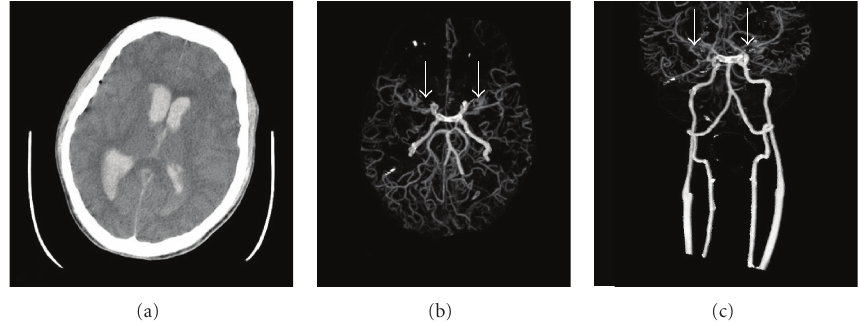
Figure 3: A 17-year-old boy was presented with sudden loss of consciousness and generalized seizure attack. Nonenhanced CT study (a) showed acute intraventricular hemorrhage. CT angiography (b, c) disclosed occlusion of bilateral prebifurcation M1 segment of middle cerebral arteries with some moyamoya vessels (arrows).